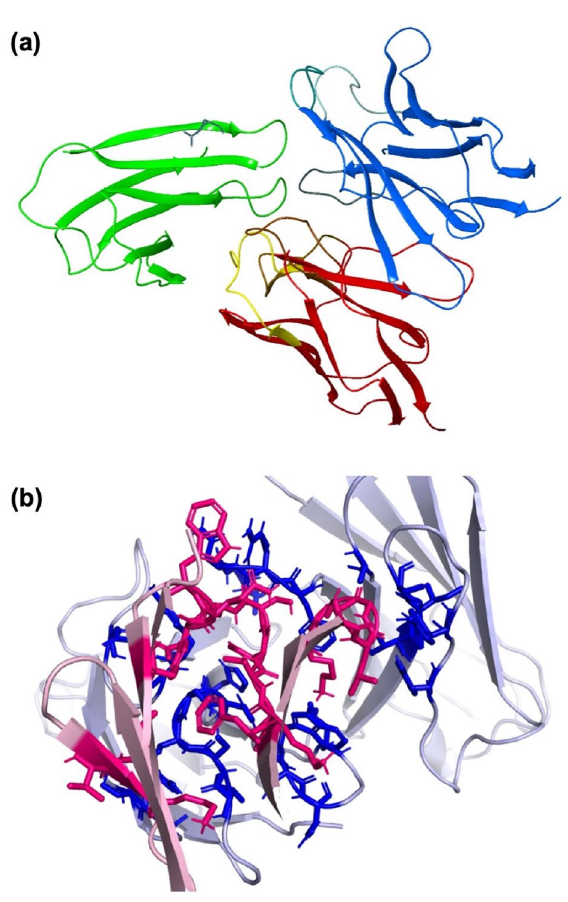
Figure 3. Model and amino acid residues participating in the interaction of HuScFvM61B9 against domain 1 of CD147. ( a ) Automatic masking of non-CDR regions of the antibody mode in ClusPro 2.0 is applied to predict the interaction coordinate of HuScFvM61B9 against domain 1 of CD147 conformational structures generated from BioLuminate 4.0. The H-chain and L-chain variable domains are shown as blue and red ribbons, respectively. The domain 1 target is depicted as a green ribbon. ( b ) The Prodigy Web server was used to elucidate the molecular interaction of the selected complex from the ClusPro 2.0 output. Based on the Pymol code automatically generated by Prodigy, the crucial side-chain residues on CDRs of HuScFvM61B9 and domain 1 (consisting of the EDLGS epitope) at the binding interface are labeled in blue and red, respectively. The predicted binding affinity (K D ) is 1.60 × 10 –8